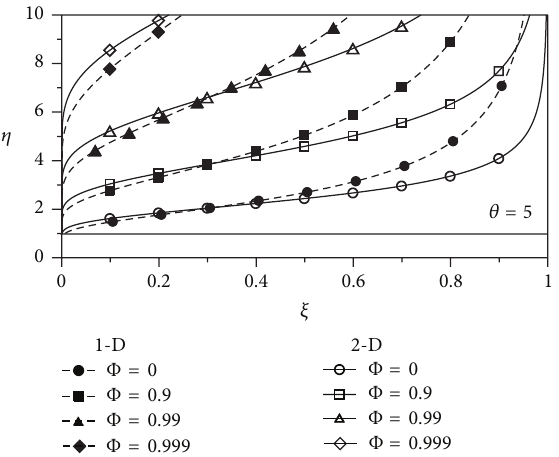
Figure 5: Optimum profiles of metal content at 𝜃 = 5 , 𝑔(𝜂) = 𝜂 2